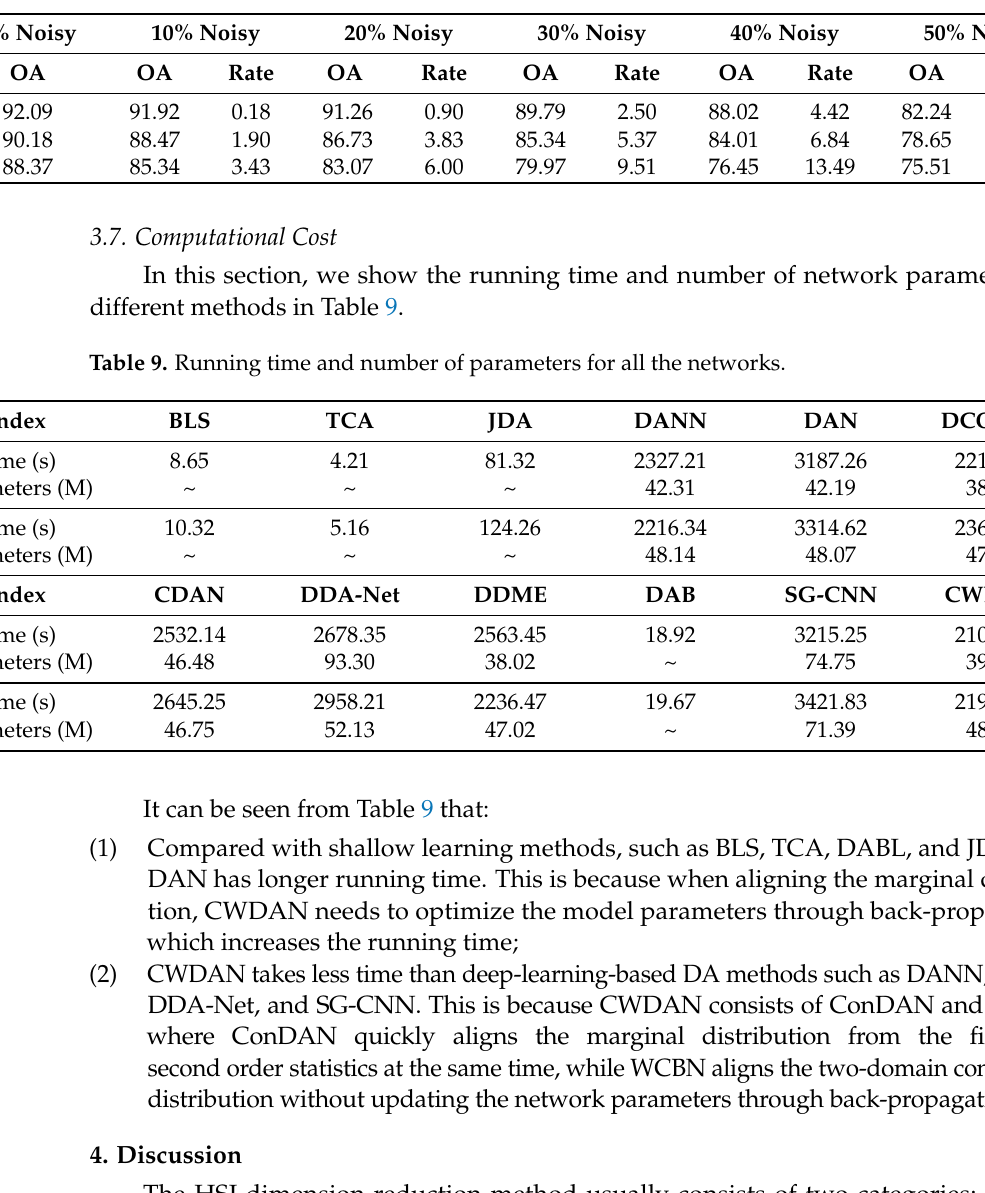
Table 8. Comparison of decline rate of OA (%) on BOT5–6.